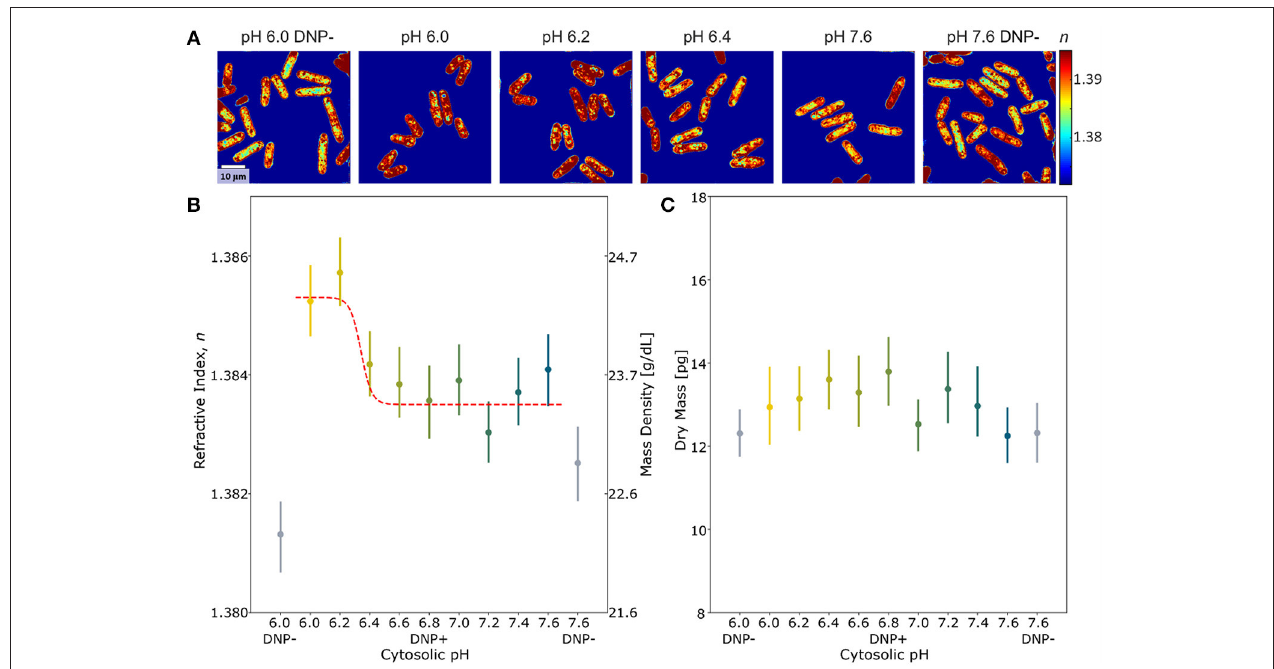
FIGURE 2 | The effect of intracellular pH on the refractive index and dry mass of S. pombe . (A) Typical cross-sectional slices of the 3D refractive index tomograms of yeast cells in the x - y plane. Two control groups of cells incubated at pH 6.0 and 7.6 in the absence of DNP are denoted by DNP − . The scale bar indicates 10 µ m. (B–C) The mean refractive index (RI) distribution (B) and the dry mass content (C) of yeast cells at different intracellular pH. the points shown correspond to the mean refractive index or dry mass measured at that pH value and lines indicate error bars (for each pH condition, N >